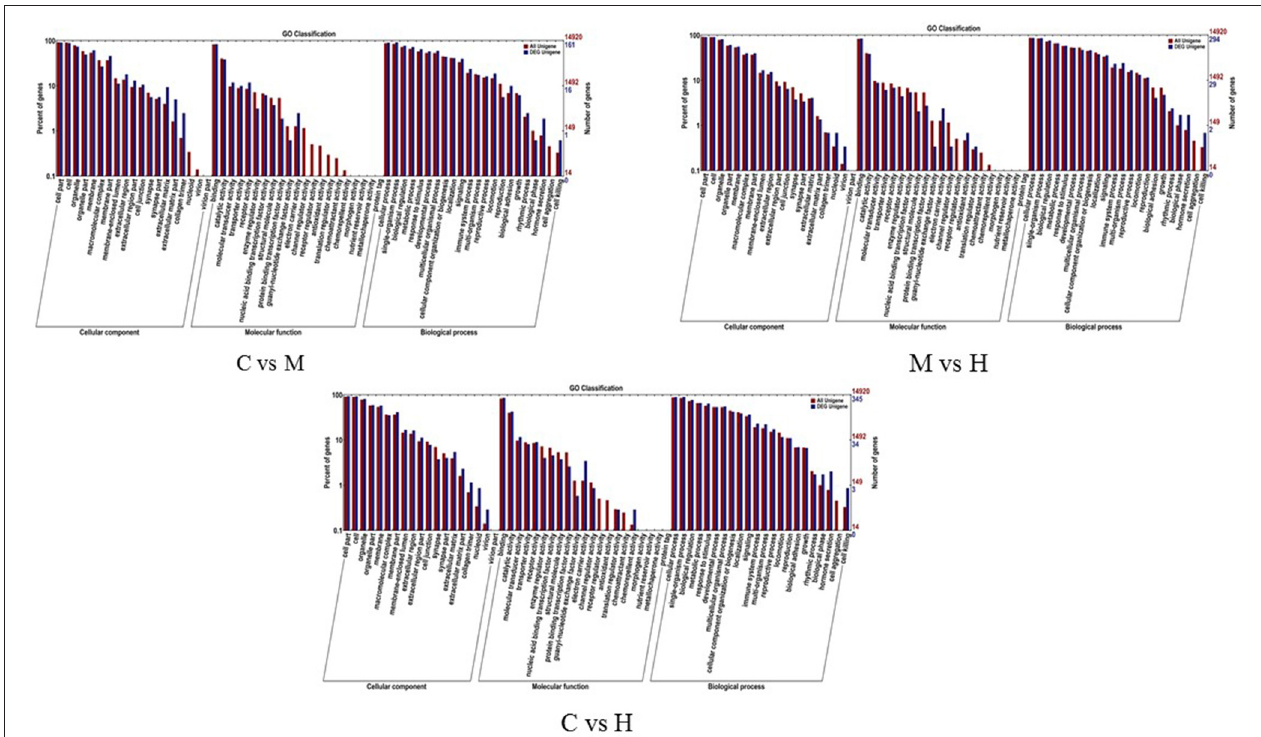
FIGURE 3 | GO enrichment analysis of the DEGs. X-axis represents the sub-categories, and the left of Y-axis represents the percentage of unigenes and the right of Y-axis represents the number of unigenes in each sub-category.